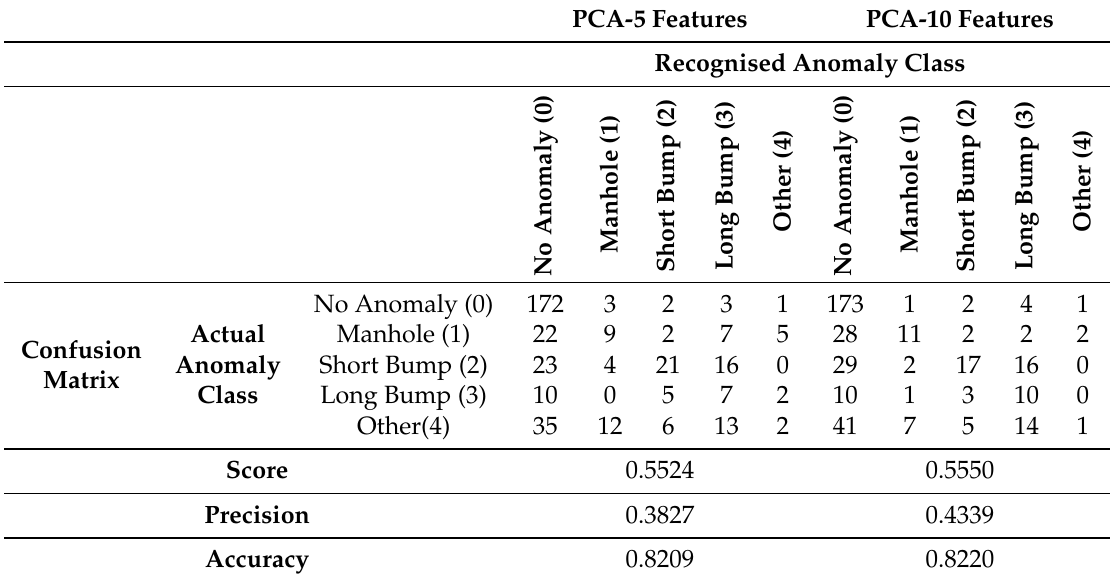
Table 7. PCA Confusion